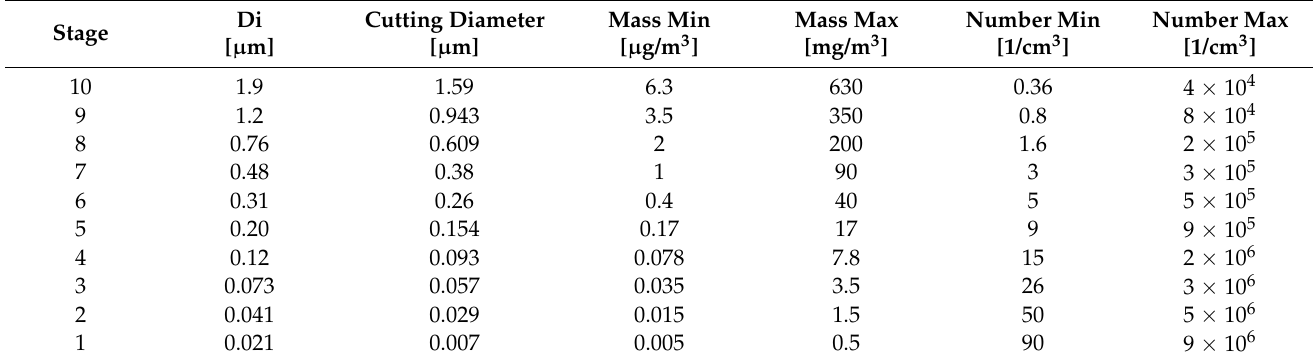
Table 4. Average particle diameters and measurement Ranges of all 10